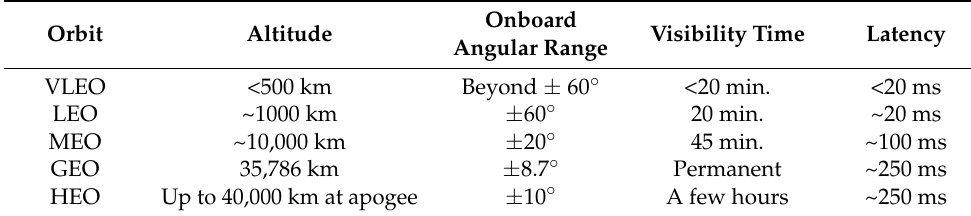
Table 3. Key parameters of typical satellite Earth